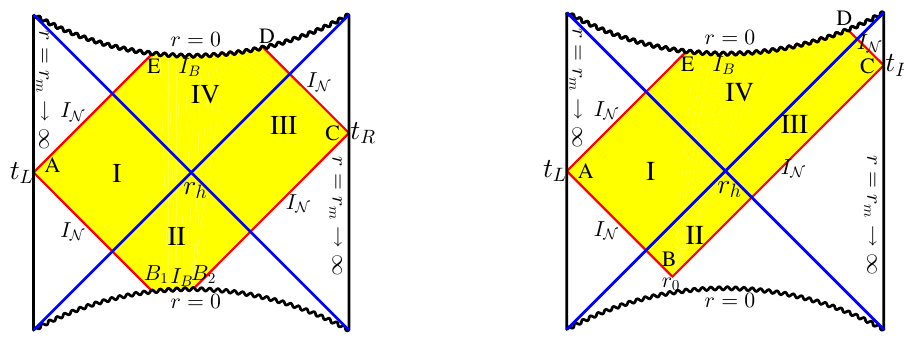
Figure 1 . Penrose diagrams and WDW patches for AdS d +1 black hole ( d (cid:21) 3) when j t R j < (cid:1) t c (left panel) and j t R j > (cid:1) t c (right panel). In the left panel, the past null sheets will meet the singularity at B 1 and B 2 respectively. In the right panel, the past null sheets will meet each other at B with r = r 0 2 (0 ; r h ). In both panels, I N and I B denote the null boundary terms and the spacelike boundary terms in (3.1) respectively. The joints A; B 1 ; B 2 ; B; C; D and E are the joints which involve at least one null boundary, so I J 0 in (3.1) are associated with those joints. There is no contribution of I J in